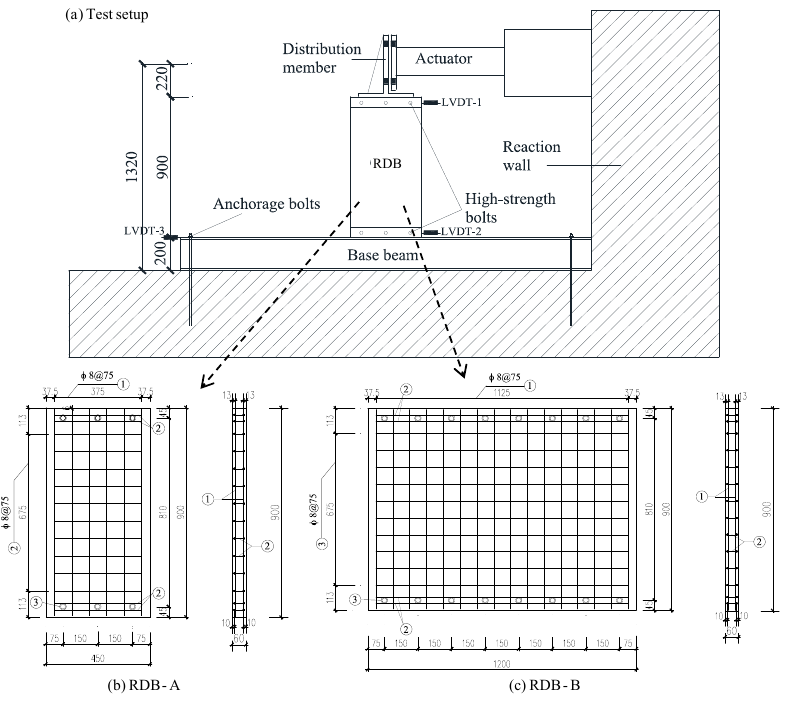
Figure 1. Test setup and test specimens.